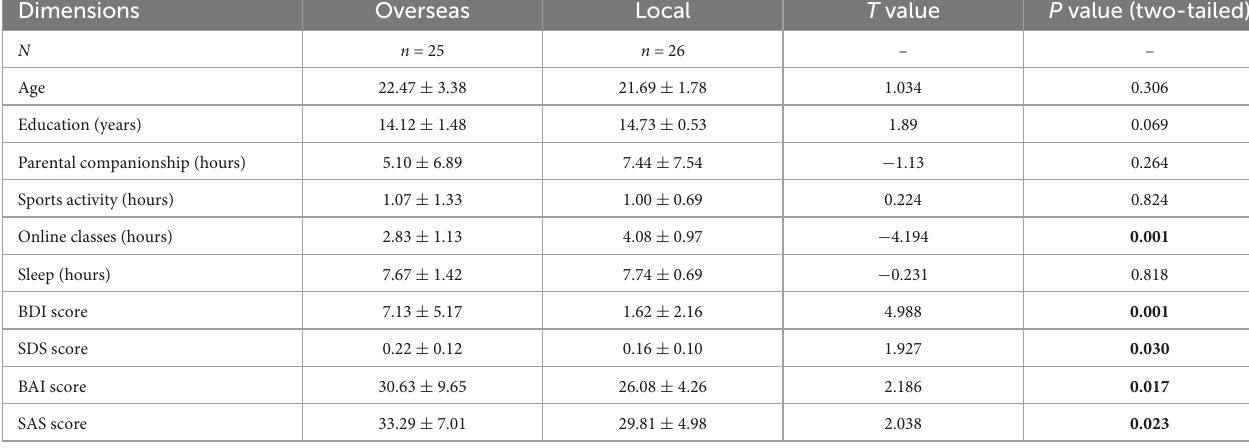
TABLE 1 Demographic and questionnaire data of college students in the overseas and local groups. Dimensions